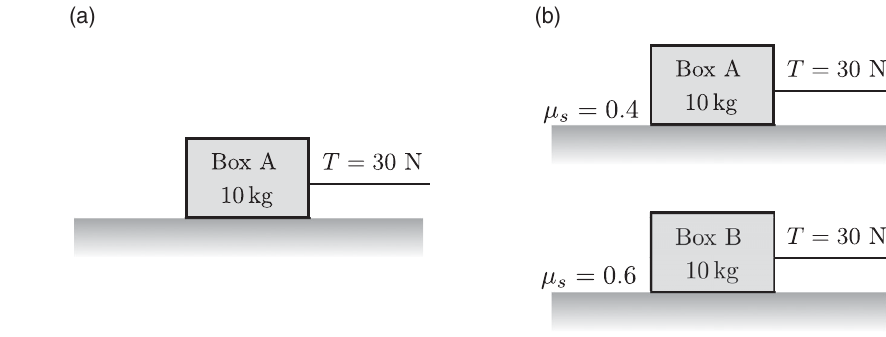
FIG. 2. Diagrams given to students for (a) the screening question and (b) the target question of the two-box friction